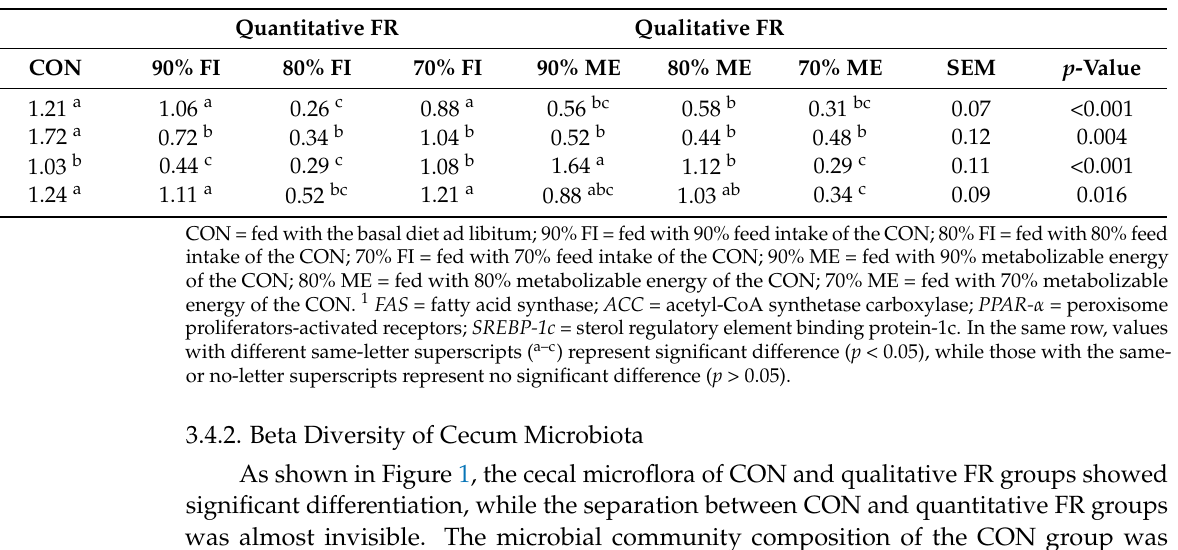
Table 4. Effects of feed restriction (FR) on mRNA expression of key genes in lipid metabolism in the livers of Bearded